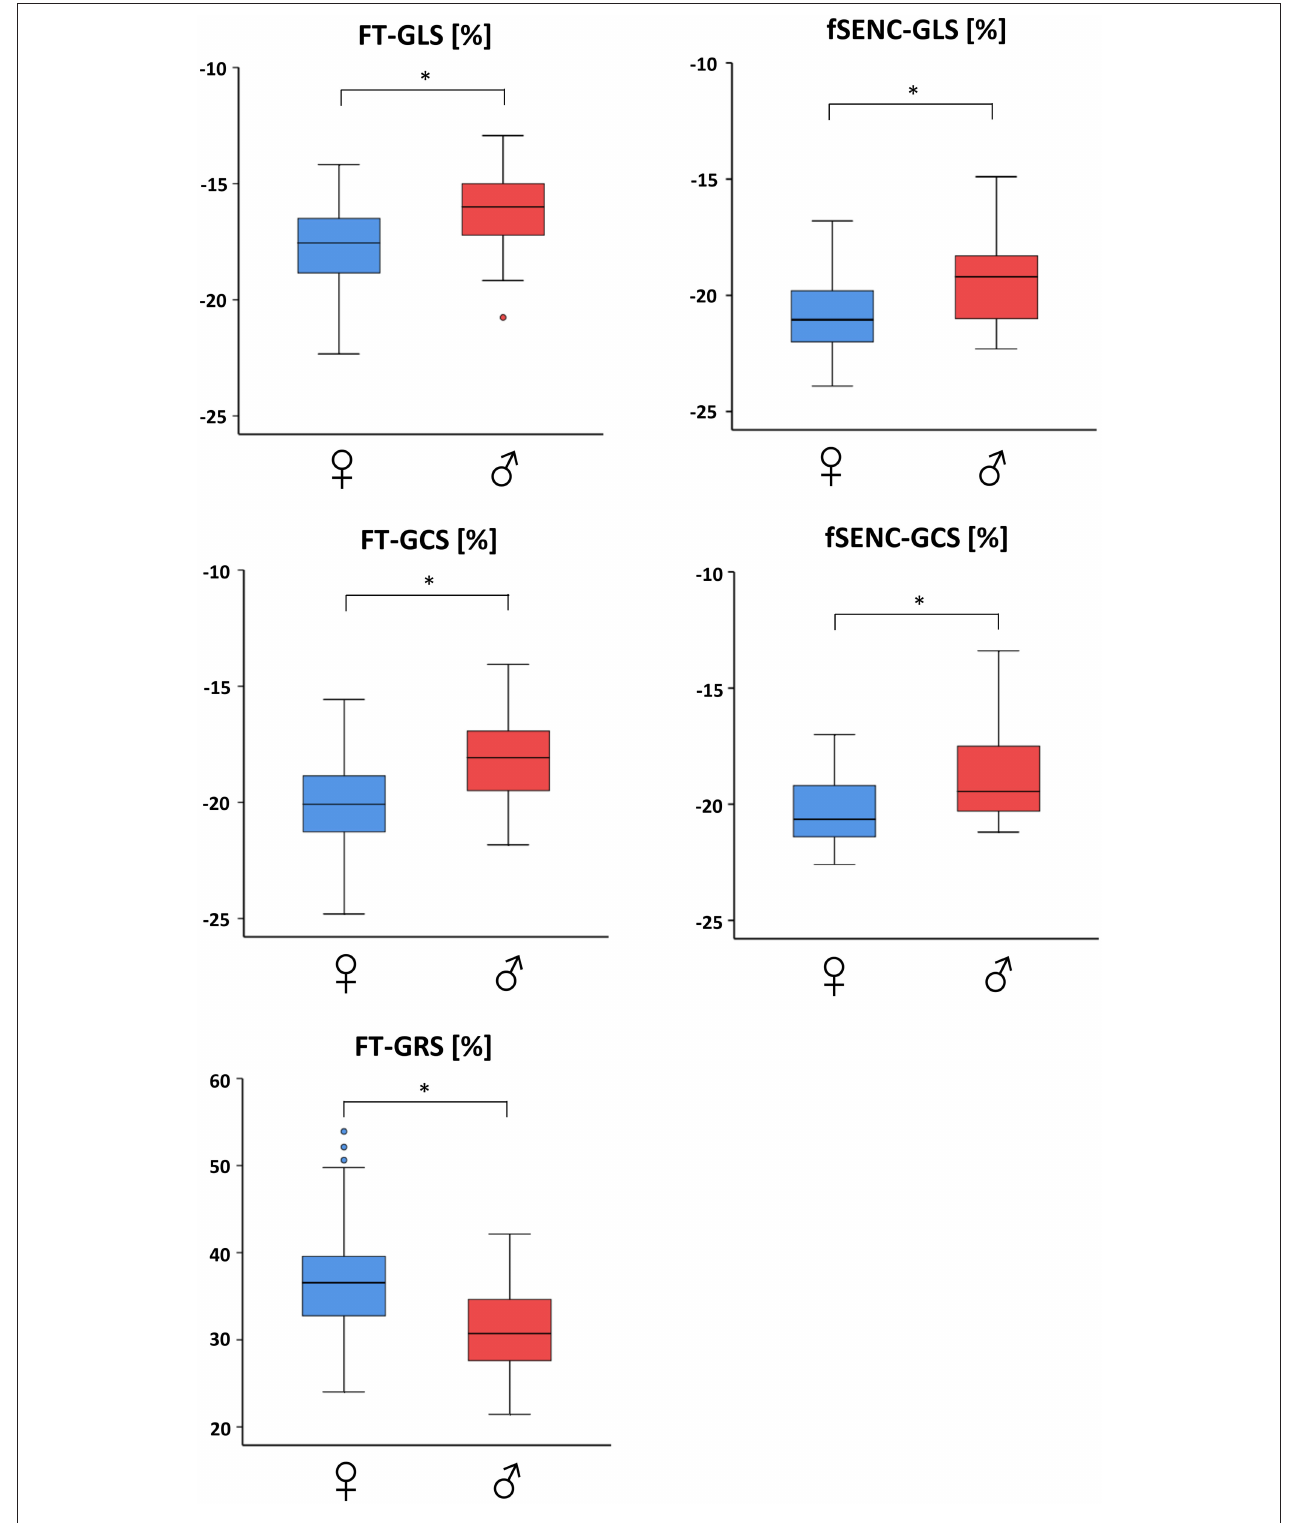
FIGURE 3 | Gender-dependent boxplots of global strain values. Strain values assessed by feature tracking (left) and fSENC (right) technique. GLS, global longitudinal strain; GCS, global circumferential strain; GRS global radial strain. * statistically significant with p < 0.05.